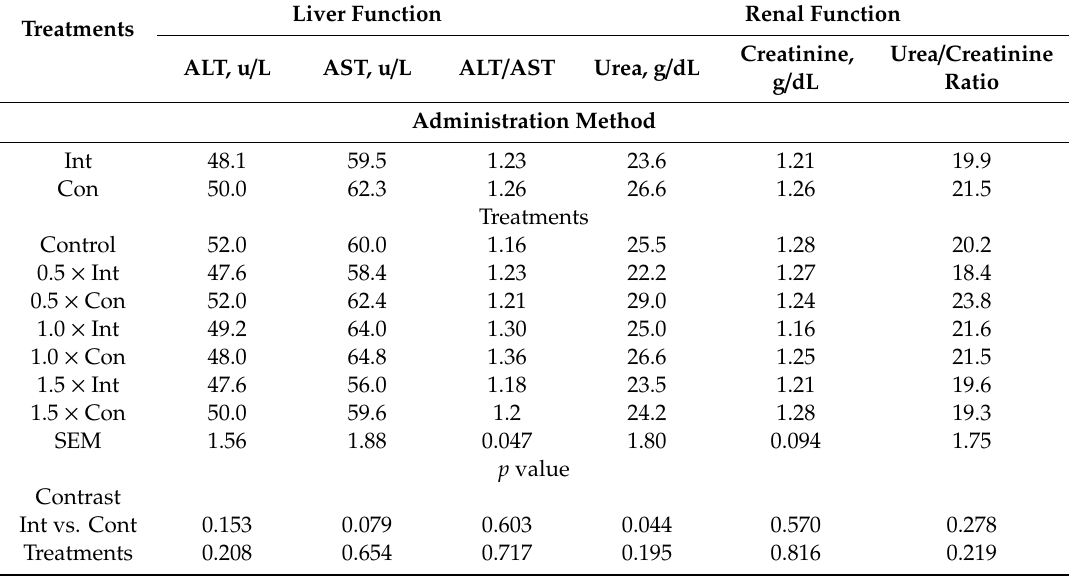
Table 8. E ff ects of multienzymes supplemented continuously or intermittently on liver function and renal function of Arbor Acres broiler chicks during 1–35 days of